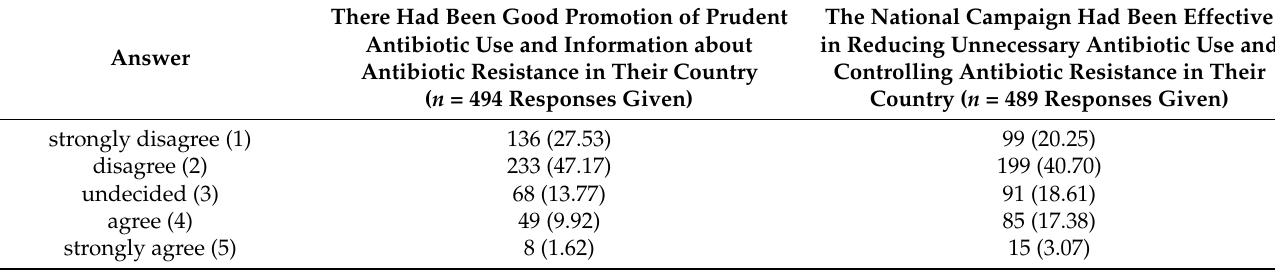
Table 6. Respondents who agreed/disagreed that there had been good promotion of prudent antibiotic use and information about antibiotic resistance in their country, and those who believed the national campaign had been effective in reducing unnecessary antibiotic use and controlling antibiotic resistance in their